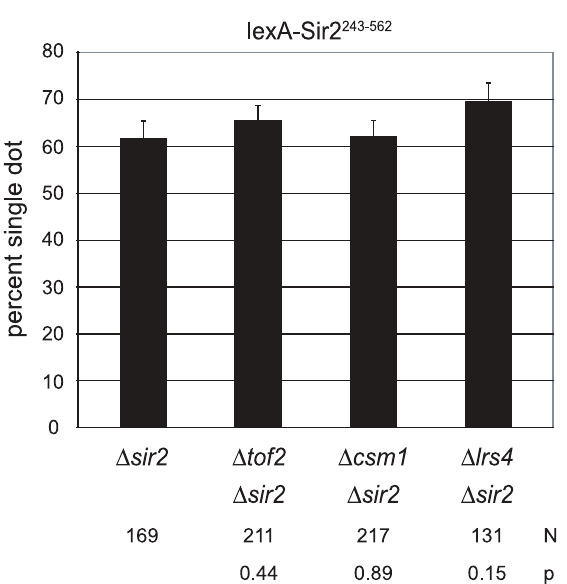
Figure 6. Binding of cohesin at HMR requires Sir2. A ) Silencing by Sir2 and the Sir3-deacetylase chimeras used as substitutes for Sir2. Strain YFC9 ( MAT a D sir2 ) bearing plasmids expressing Sir2 (pCC7), Sir3- Hos3 2–549 (pCC10), Sir3-Sir2 243–562 (pCC4), Sir3-Hos3 2–549 -Sir2 499–562 (pYFC14) or empty vector (pRS414) was mated with tester strain K125 ( MAT a hom3 ilv1 ). SC-trp plates monitored growth of the YFC9 transformants and SD plates monitored mating. B ) Cohesion by Sir3-